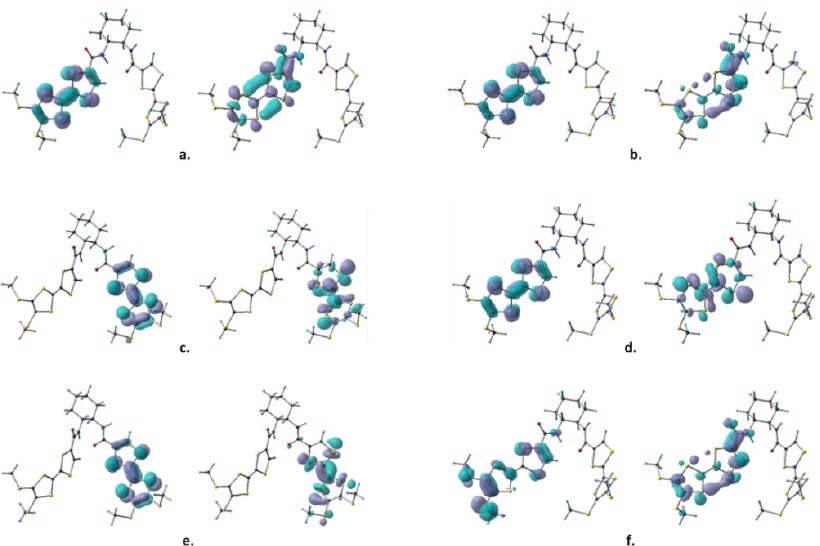
Figure 12. Most relevant frontier MOs involved in the monoelectronic excitations computed for compound ( R , R )- 1 at the B3LYP/Def2-SVPD level of theory. Brief description of the MOs: HOMO-3 to HOMO: π orbital on the two TTF units; LUMO and LUMO+1: π* orbitals on the two different arms of compound ( R , R )- 1 ; LUMO+2 and LUMO+3: σ* orbital on the TTF units.